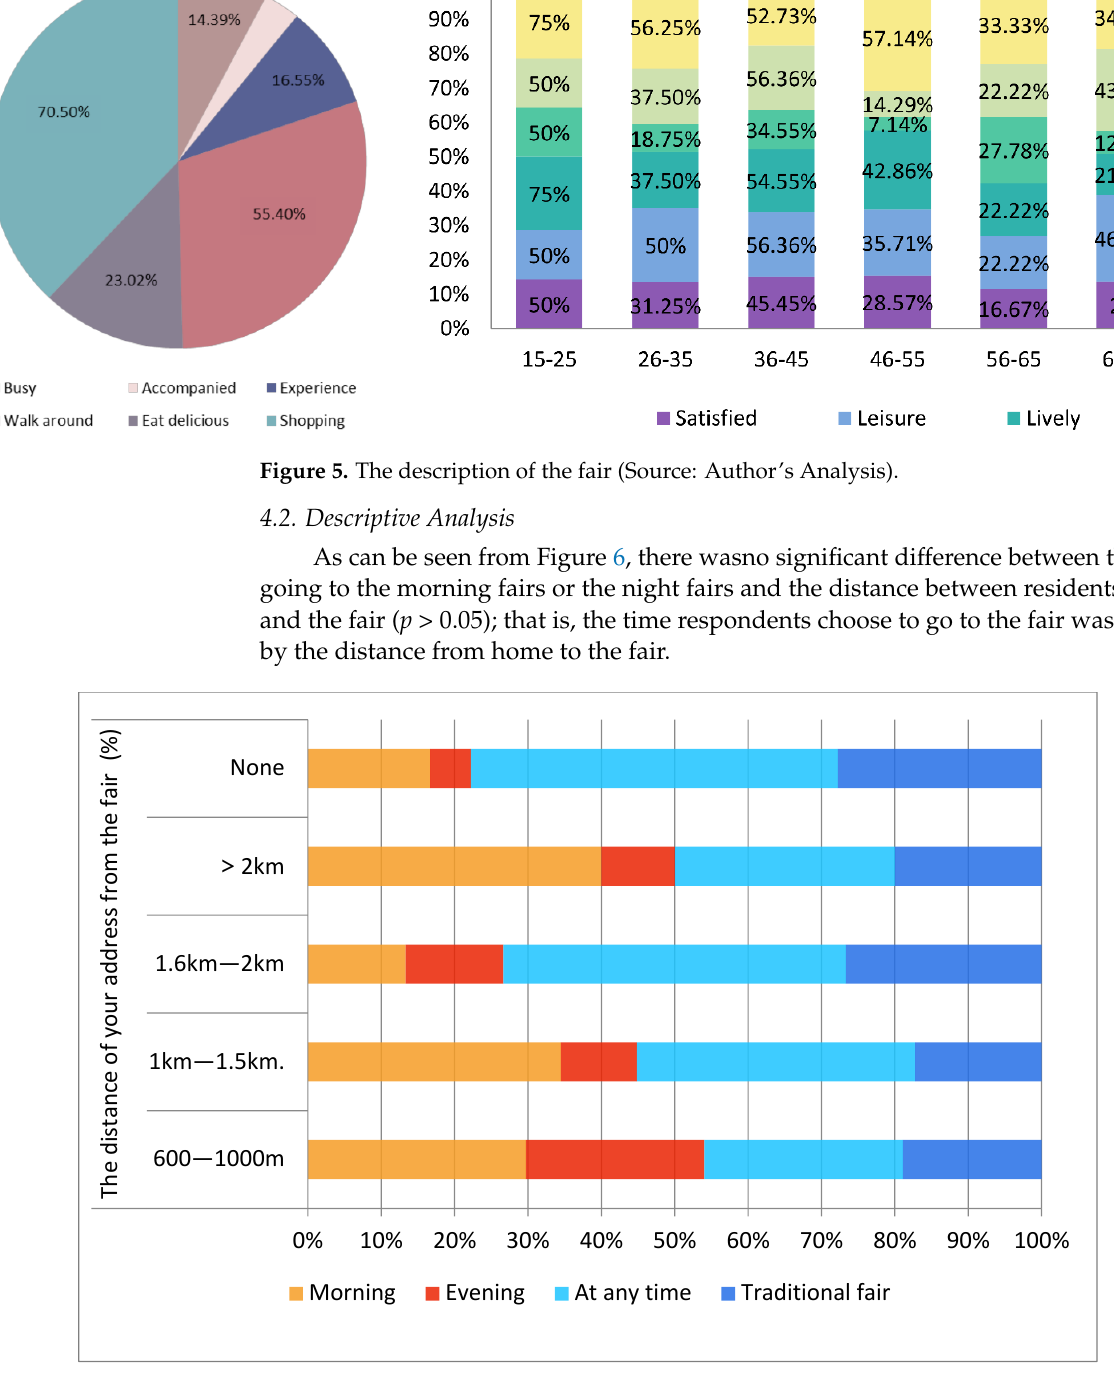
Table 2. Analysis of gender and age in choosing supermarket and fair . Profiles